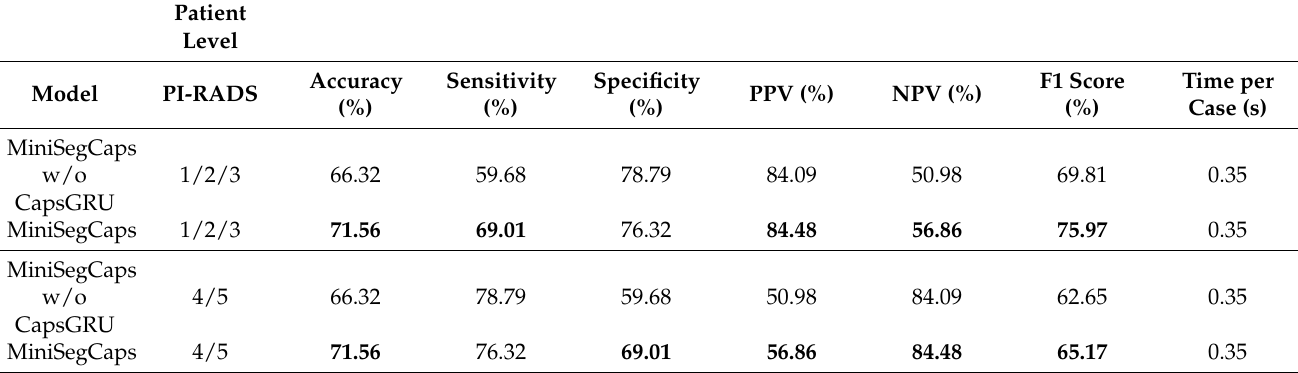
Table 12. Comparison of the patient-level performance between our method and baseline methods in PI-RADS classification of prostate